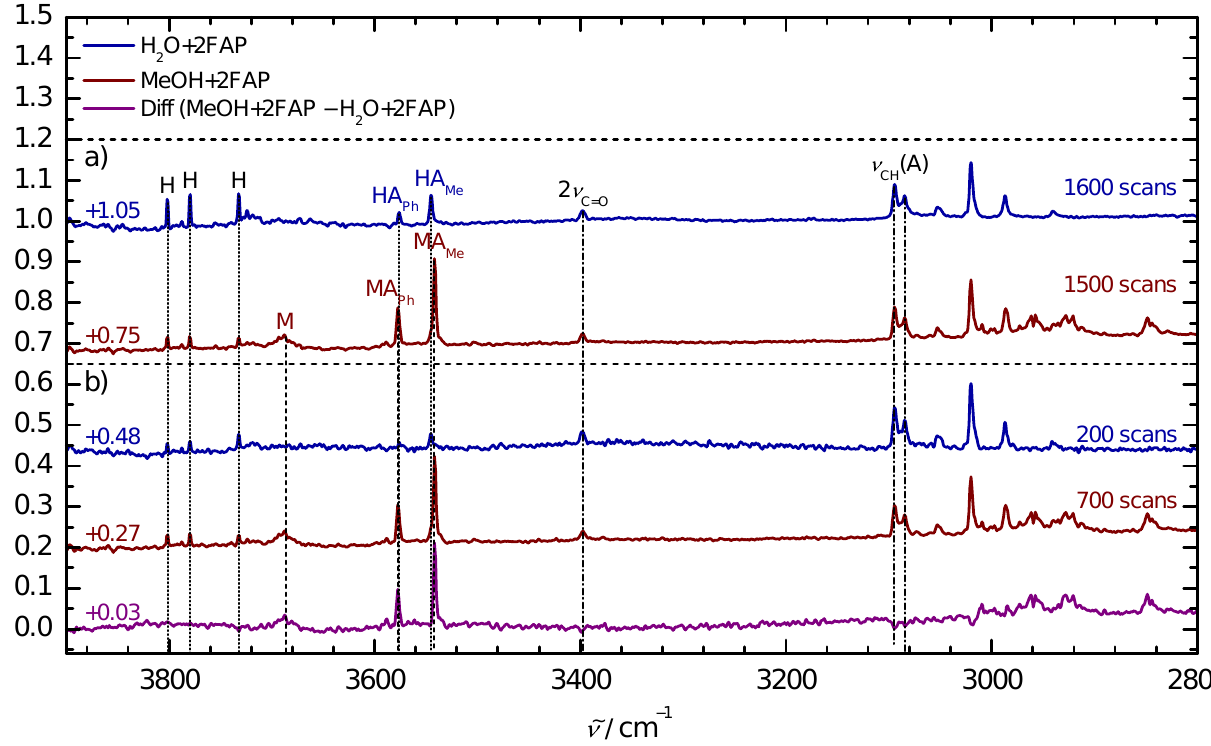
Figure 9. Influence of the water impurity on spectra of a binary mixture of MeOH and 2FAP in He. ( a ) spectrum (1600 scans) of 2FAP in He, with water impurity (blue); spectrum (1500 scans) of MeOH+2FAP in He (red). ( b ) subsets (see number of scans above the baselines) of the spectra in ( a ), containing similar amounts of the water impurity, and their difference spectrum (purple = red − blue). The most important spectral features are marked (H: water monomer; M: MeOH monomer; HA Me/Ph : H 2 O+2FAP dimer, bound on methyl (Me) or phenyl (Ph) side; MA Me/Ph : MeOH+2FAP dimer; 2 ν C = O : C = O stretch overtone; ν CH (A): CH stretching bands of 2FAP (A)). The spectra are displaced along the ordinate as indicated above their respective